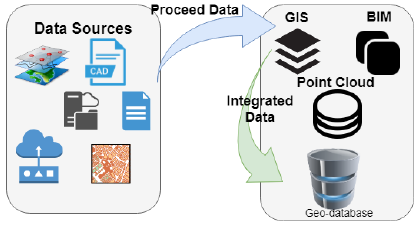
Figure 2. An integrated